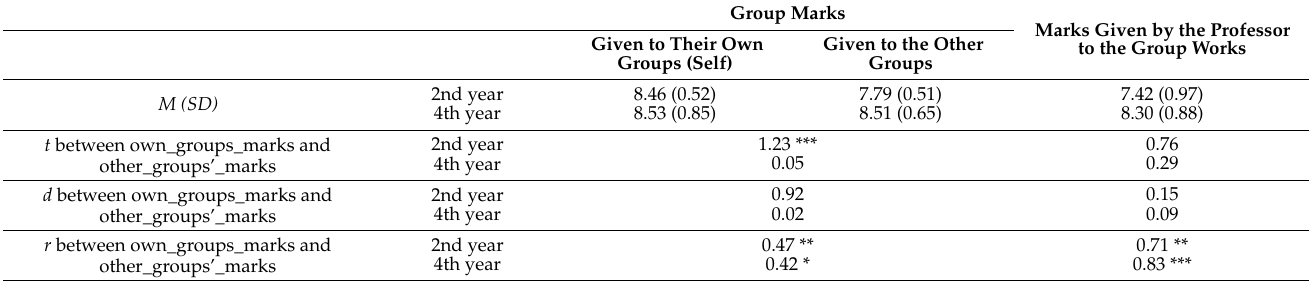
Table 3. Co-assessment analyses regarding their own groups (self-assessments) and all the other groups.